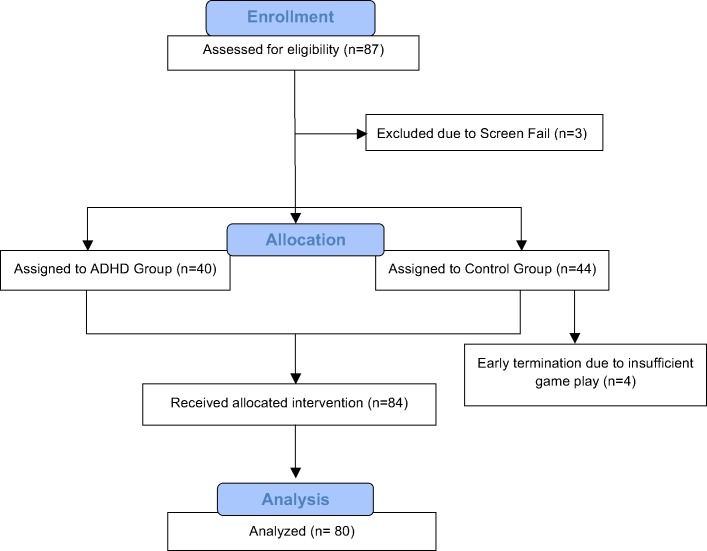
CONSORT flow diagram.